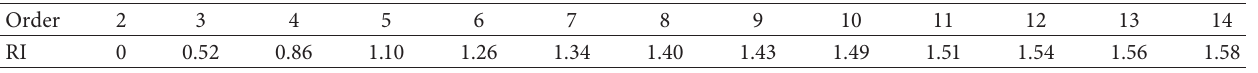
Table 4: The mean random consistency index.